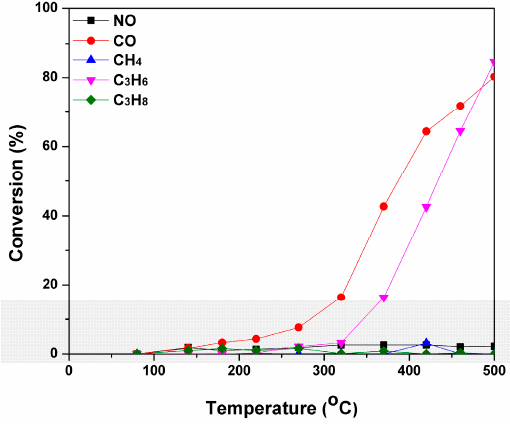
Figure 10. Light ‐ off curves of sample Cu_2.4 wt %_SiO 2 _Tris. Figure 10. Light-off curves of sample Cu_2.4 wt %_SiO